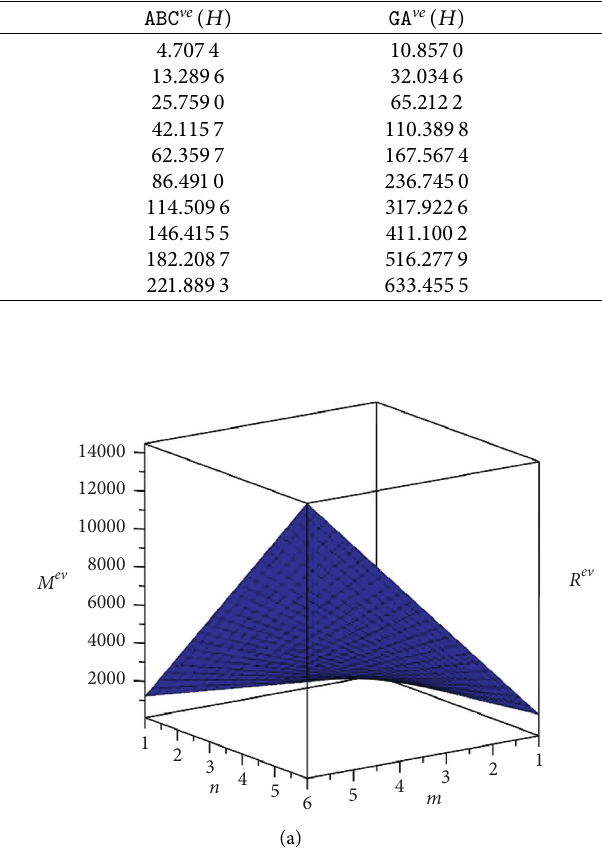
Figure 2: 3D plot of (a) M ev ( VC [ m, n ]) (b) R ev ( VC [ m, n ])